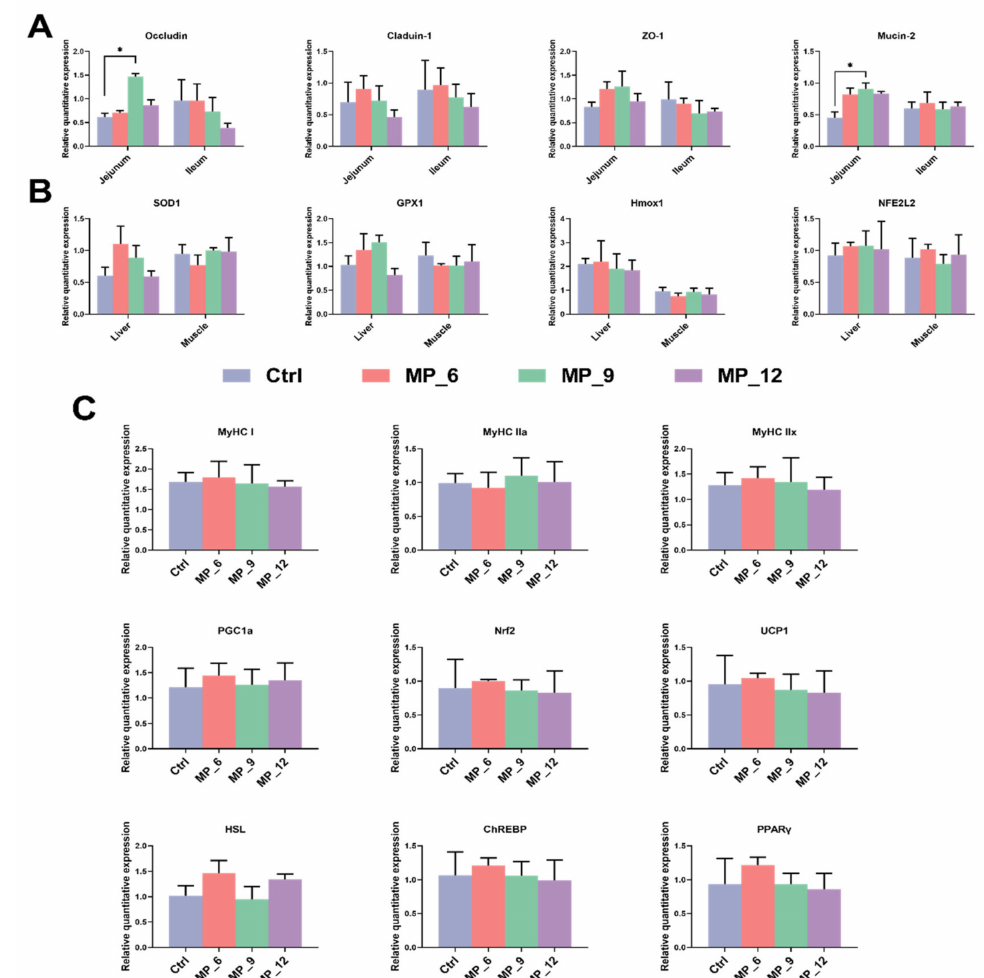
Figure 3. Relative quantitative expression associated with intestinal function ( A ) and antioxidant ca- pacity ( B ), as well as muscle fiber and lipid metabolism ( C ) in finishing pigs dietary supplementation of mulberry leaf powder of varying levels. ZO-1, zonula occludens-1; SOD1, superoxide dismutase; GPX1, glutathione peroxidase 1; Hmox1, heme oxygenase 1; NFE2L2, nuclear factor erythroid 2-like 2; MyHC1, myosin heavy chain 1; MyHC IIa, myosin heavy chain IIa; MyHC IIx myosin heavy chain IIx; PGC-1 α , peroxisome proliferator-activated receptor γ coactivator-1 α ; Nrf2, nuclear respiratory factor; UCP1, uncoupling protein-1; HSL, hormone-sensitive lipase; ChREBP, carbohydrate response element binding protein; PPAR γ , peroxisome proliferator-activated receptor γ . Ctrl, basal diet with 0% MP; MP_6, MP_9 and MP_12 are the basal diets supplemented with 6%, 9% and 12% MP, respectively. Data were displayed as mean ± SEM. Bar with different asterisk (*) indicated the degree of significant difference. n = 3. *, p <